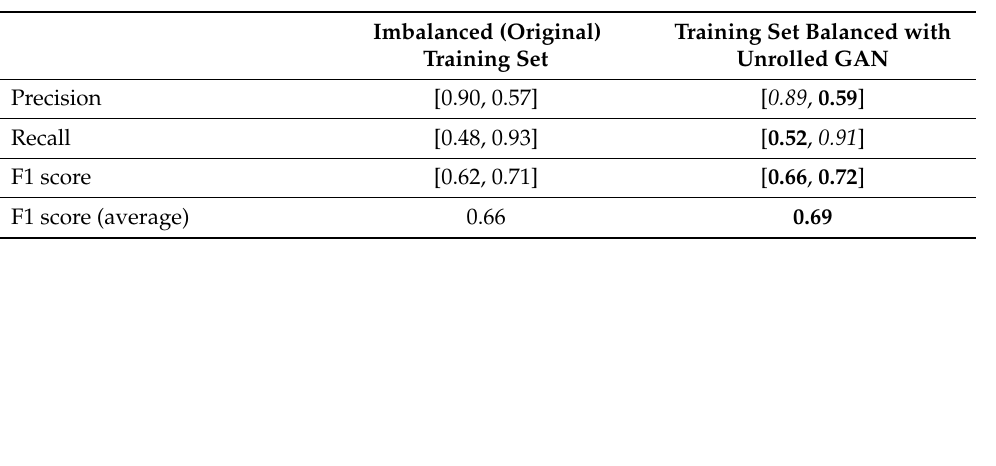
Table 2. The effect of training set augmentation for the SonyAIBORobotSurface1